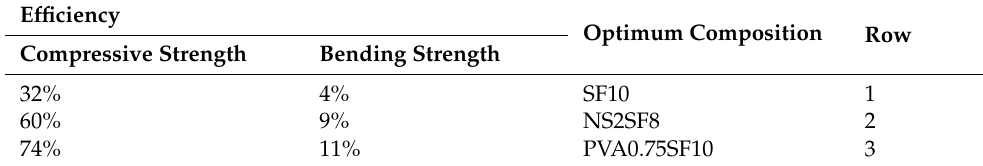
Table 14. The efficiency of the optimum